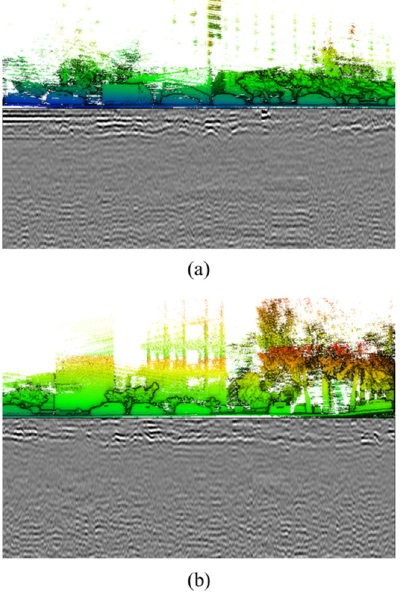
Figure 12. 3D p oint cloud map profile